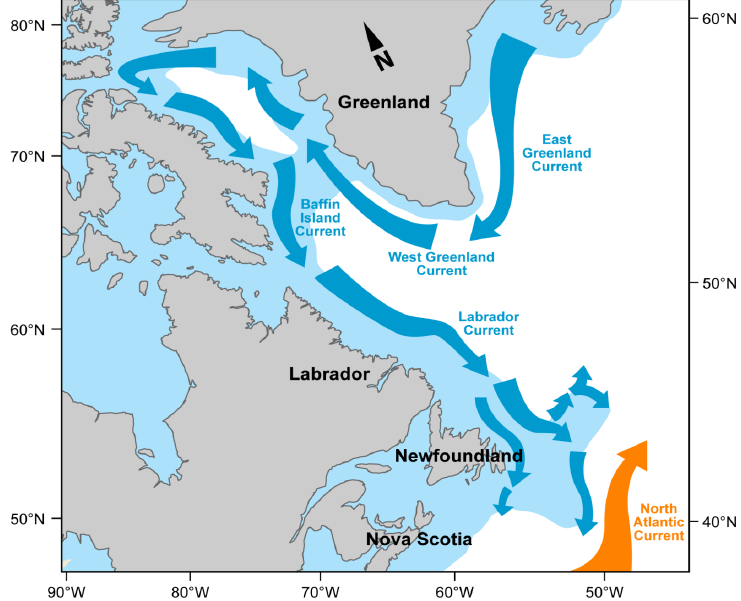
Figure 10. Sea currents effecting sea bottom temperatures offshore